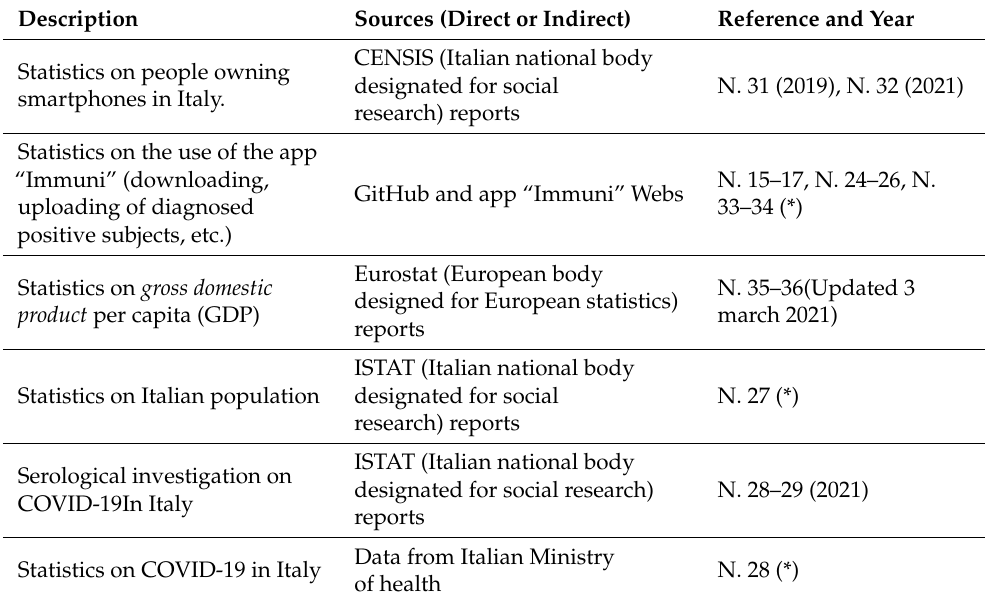
Table 1. Summary table with the description of the data considered, the direct or indirect source, and the references (* accessed at the date of writing, 5 October